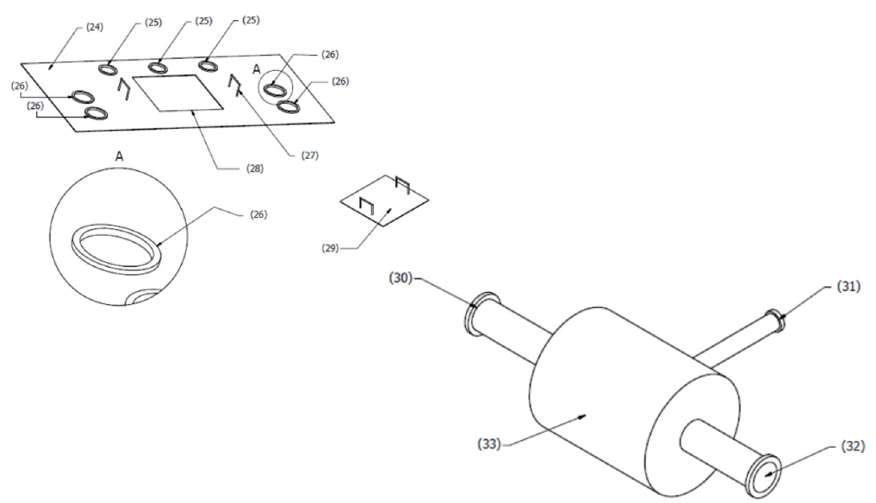
Figure A3. Diagram of the bioreactor lid (top) and air mixer. Source: References [18,19]. [Reprinted from: Nova Science Publishers, Solid-State Cultivation of Grifola frondosa and Ganoderma lucidum: Technology, Research and Possibilities for Waste Utilization in Tropical Weathers, pp. 284, copyright (2020) Montoya, S.; Sánchez, Ó.J.; Arias, D.F. The statement, with permission from Nova Science Publishers, Inc.] The bioreactor is provided with a control box for the temperature and relative hu- midity comprising a thermocouple selector, a display for six temperature points, a relative humidity display, a power-on indicator light, a general switch, and a power-off indicator light. The bioreactor also has an air mixer (33) that consists of a fresh air entrance (30 in Figure A3), an air recirculation pipe (31), an air exit towards the bioreactor (32), and a mixing tank for fresh and recycled air (33). There are stainless steel pipes with a double air expansion device and a mixer for injecting recirculating air when the bioreactor is working with forced aeration (2 in Figure